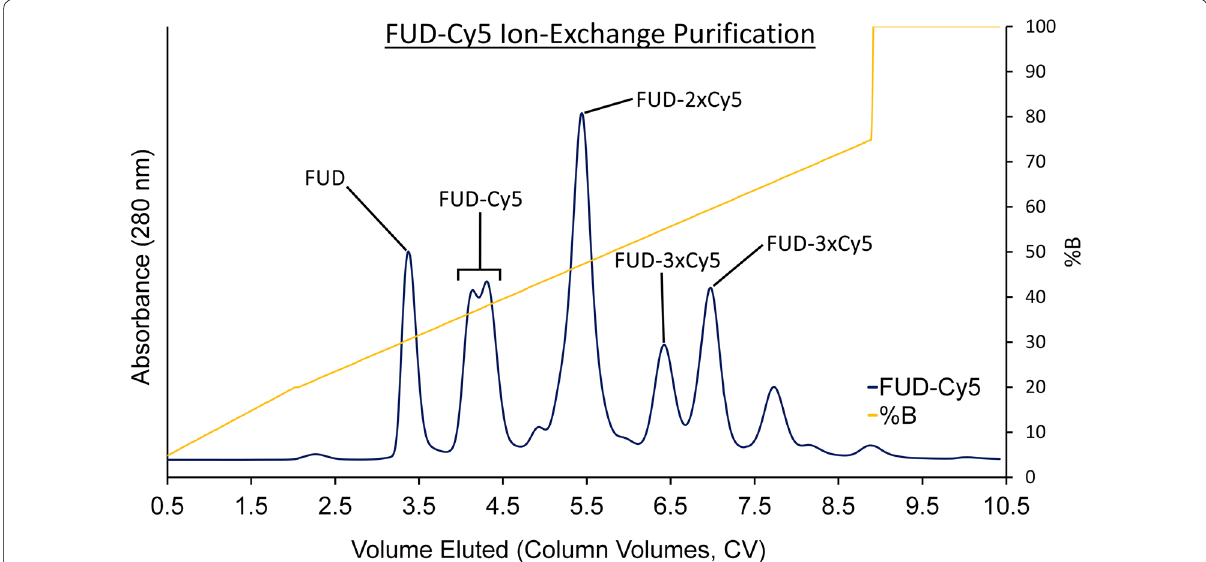
Fig. 2 Ion-exchange (IEX) chromatogram showing separation of singly labeled FUD-Cy5 from unreacted and multiply labeled FUD. The sample was loaded onto an anionic exchanger and eluted via application of a mobile phase gradient containing 20 mM Tris (pH 8) in the A side and 1 M NaCl in 20 mM Tris Buffer (pH 8) in the B